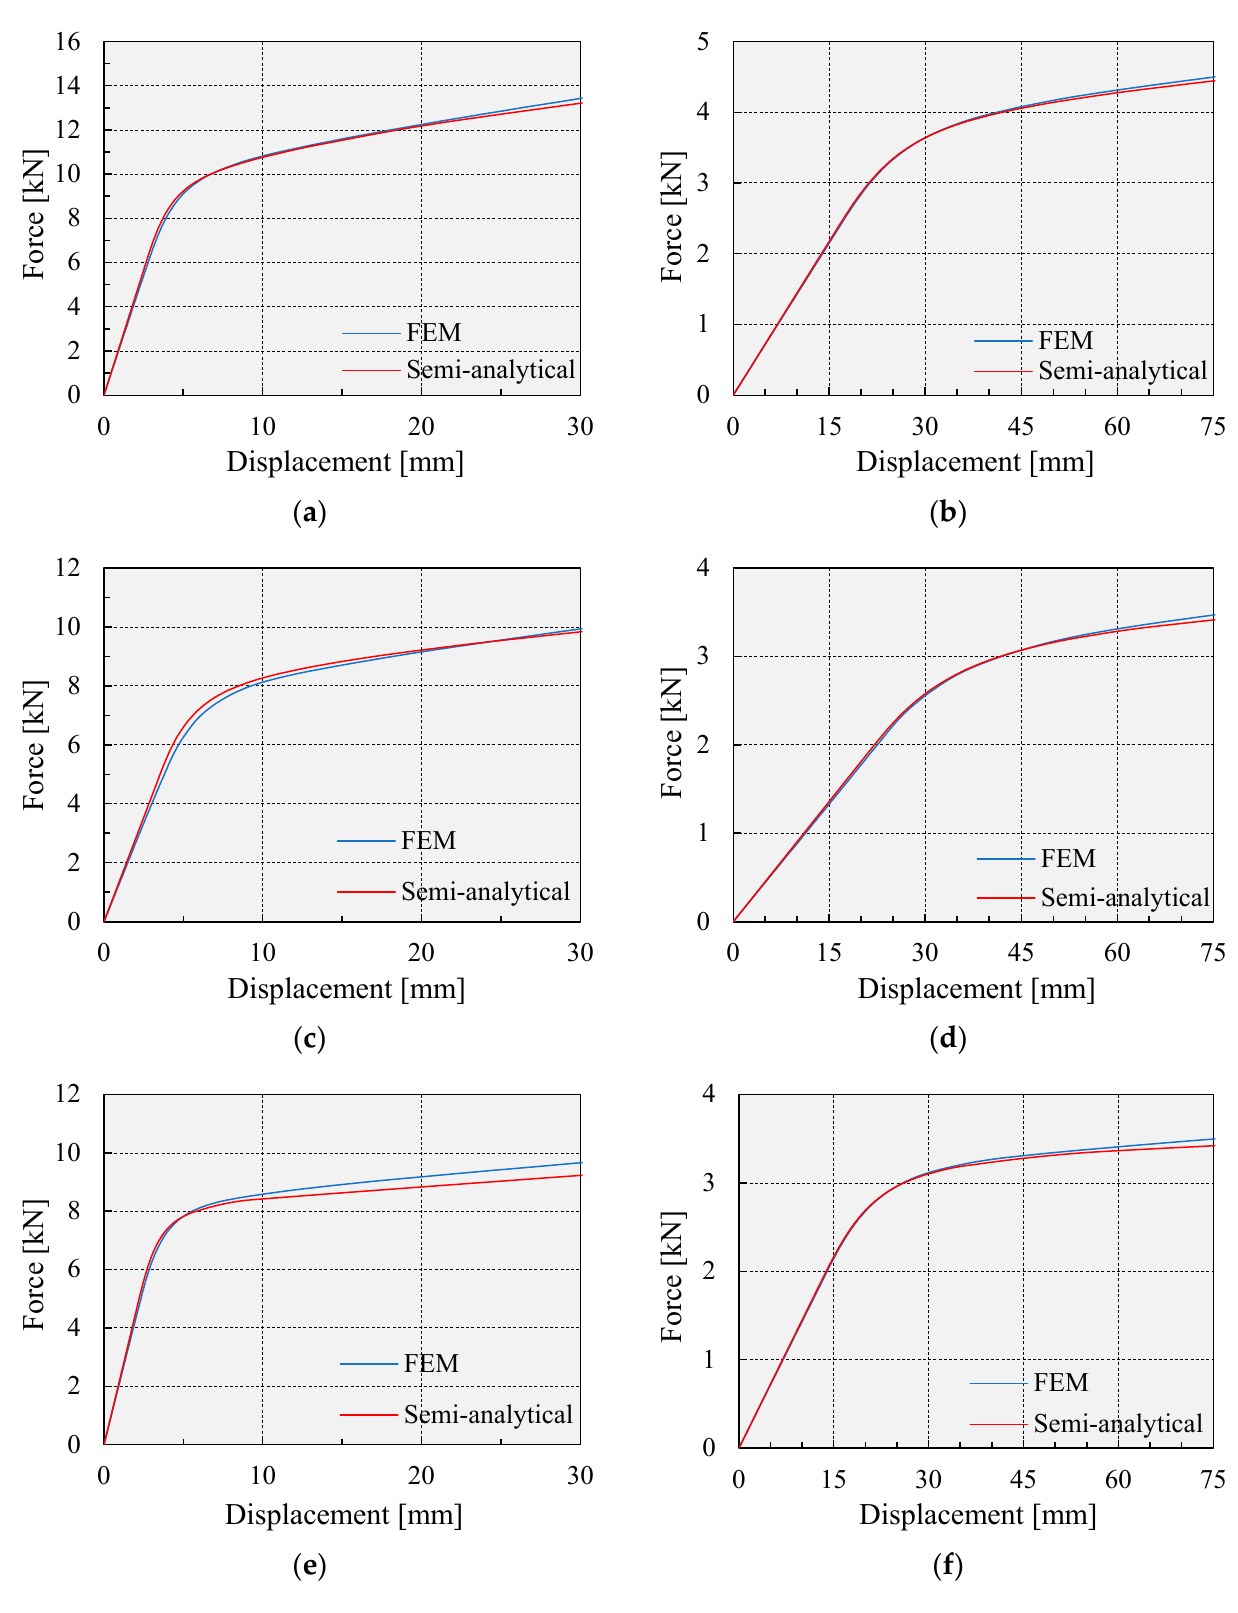
Figure 15. Force–displacement diagrams for cantilever beam models: ( a ) C1; ( b ) C2; ( c ) C3; ( d ) C4; ( e ) C5; ( f ) C6.